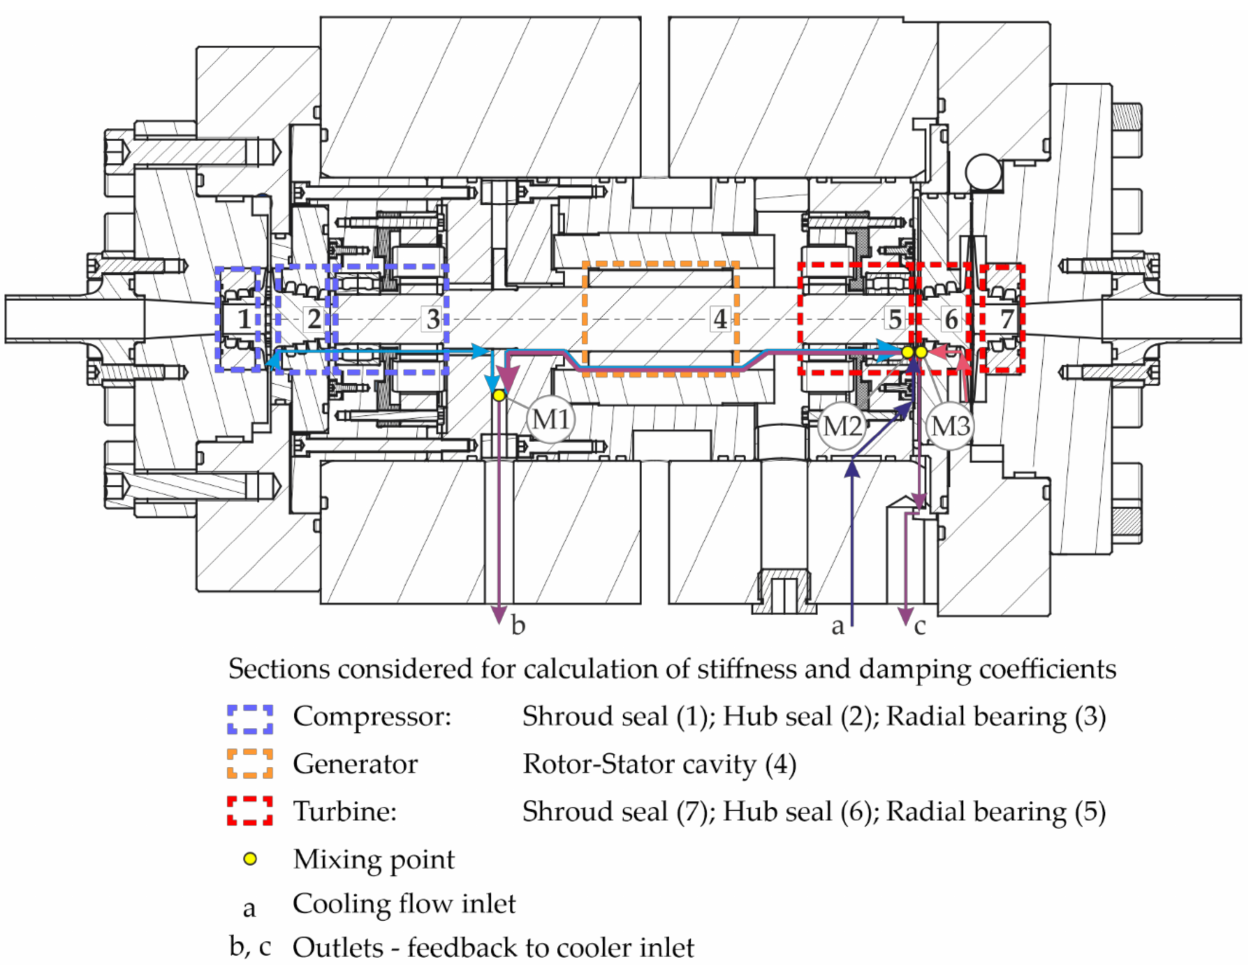
Figure 2. Sections considered for calculation of stiffness and damping